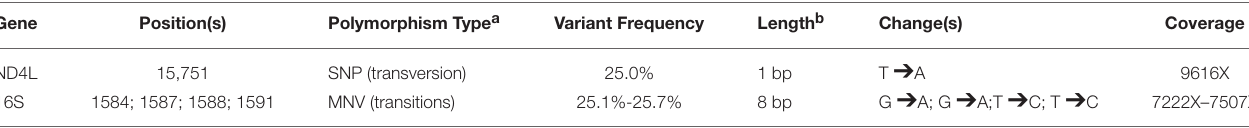
TABLE 3 | Nucleotide polymorphisms detected in the A. limnaeus mtgenome using the Geneious variant caller. Gene Position(s) Polymorphism Type a Variant Frequency Length b Change(s) Coverage : ND4L 15,751 SNP (transversion) 25.0% 1 bp T A 9616X MNV